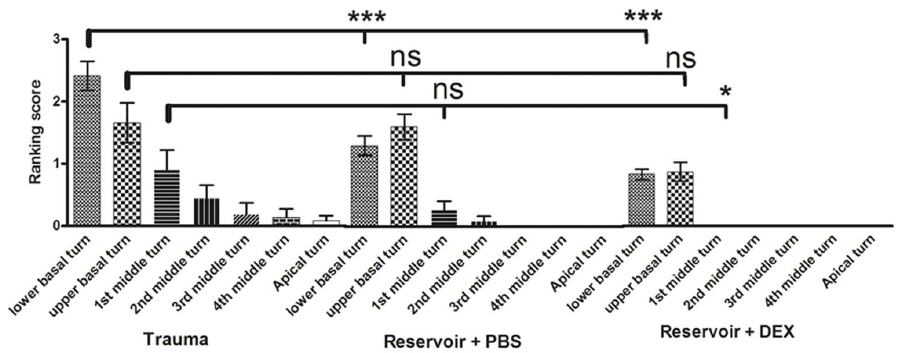
Figure 5. Distribution of fibrosis regarding subjective ranking for all inner ear turns and all experimental groups. In all groups the highest extend of connective tissue growth was detected in the basal turns. Fibroblast growth in more apical turns was only detected in the trauma group and did not take place in reservoir groups at all. Significant differences between the groups were detected (plotted above the SEM bars: *=p , 0.05, ***=p , 0.001; reference of the significance is marked by the thick bar) and were most prominent in the lower basal turns (p , 0.001). Even though there seems to be a tendency of increased tissue formation in the PBS group compared to the DEX group there is no statistical relevance detectable using One-way ANOVA in combination with the Tukey post-test to compare the means between